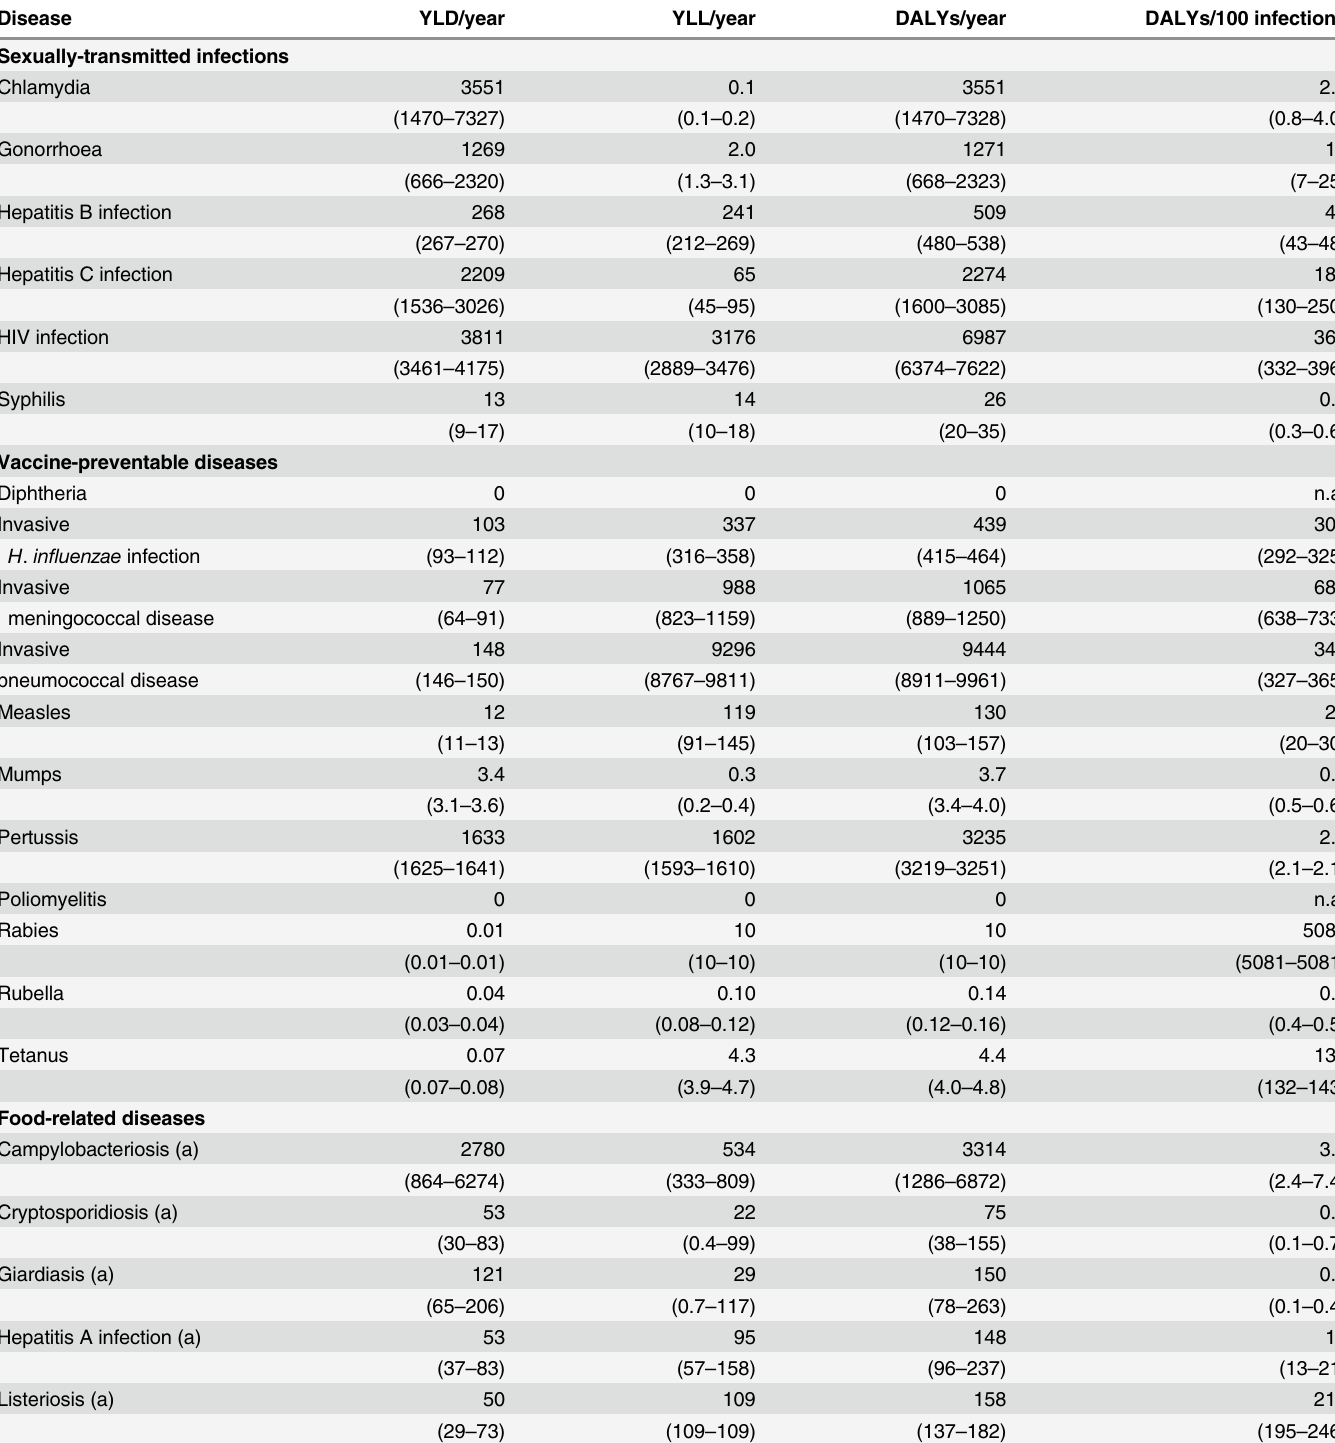
Table 2. Estimated annual disease burden in the period 2007 – 2011 for new cases of sexually-transmitted infections, vaccine-preventable dis- eases, food-related diseases, and respiratory diseases: mean (with 95% uncertainty intervals) YLD/year, YLL/year, DALYs/year, and DALYs/100